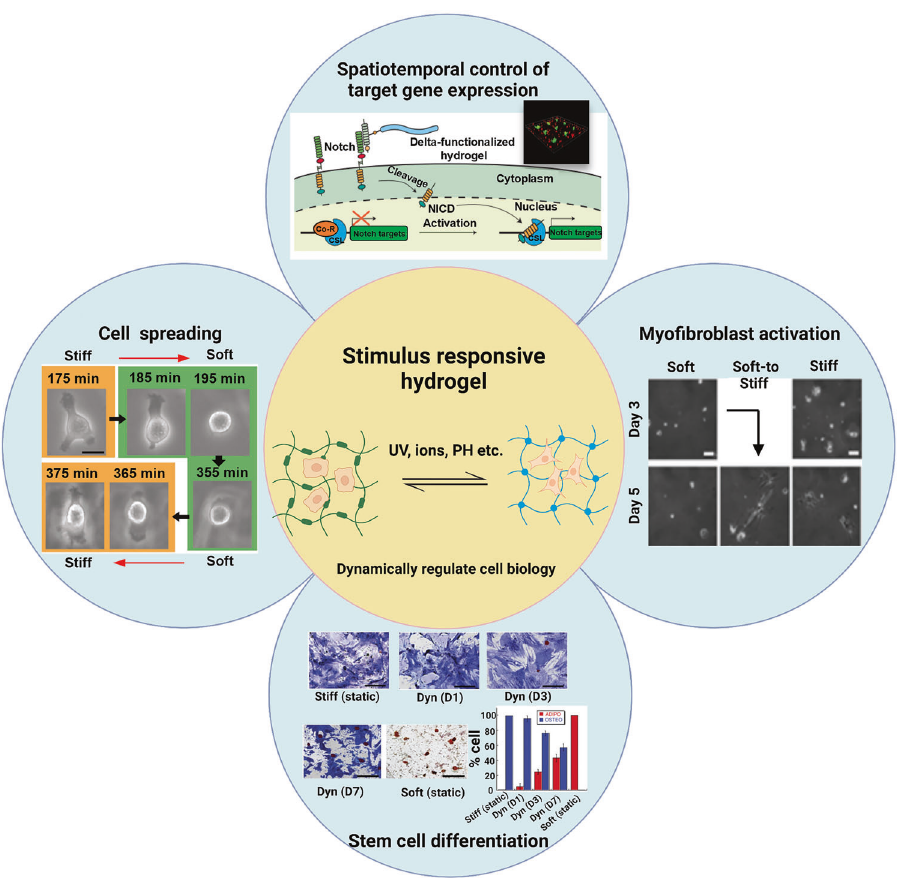
Fig. 10 In fl uence recapitulation of stimulus-responsive hydrogels on dynamic cell microenvironment, spatiotemporal cell spreading control, 318 target gene expression, 322 myo fi broblast activation, 35 and stem cell differentiation. 37 Adapted with permission from ref. 318 Copyright